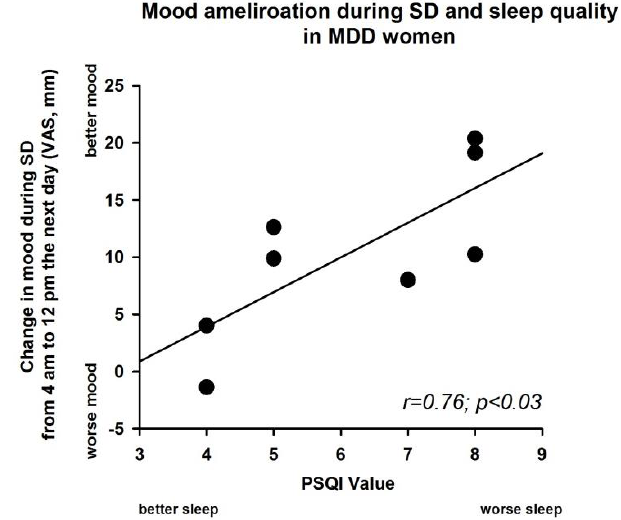
Figure 3. Linear regression between the values of the Pittsburgh Sleep Quality Index (PSQI) at baseline and the values of mood change from the visual analogue scale in the high sleep pressure protocol for MDD women ( r = 0.76; p < 0.03). This figure shows the difference of subjective mood between clock time 4 a.m. (20-h after elapsed time awake) and clock time 12 p.m. (28-h after elapsed time awake) (see Figure 2, high sleep pressure protocol). X -axis: PSQI values; Y -axis, VAS of subjective mood. Black dots correspond to individual participants.